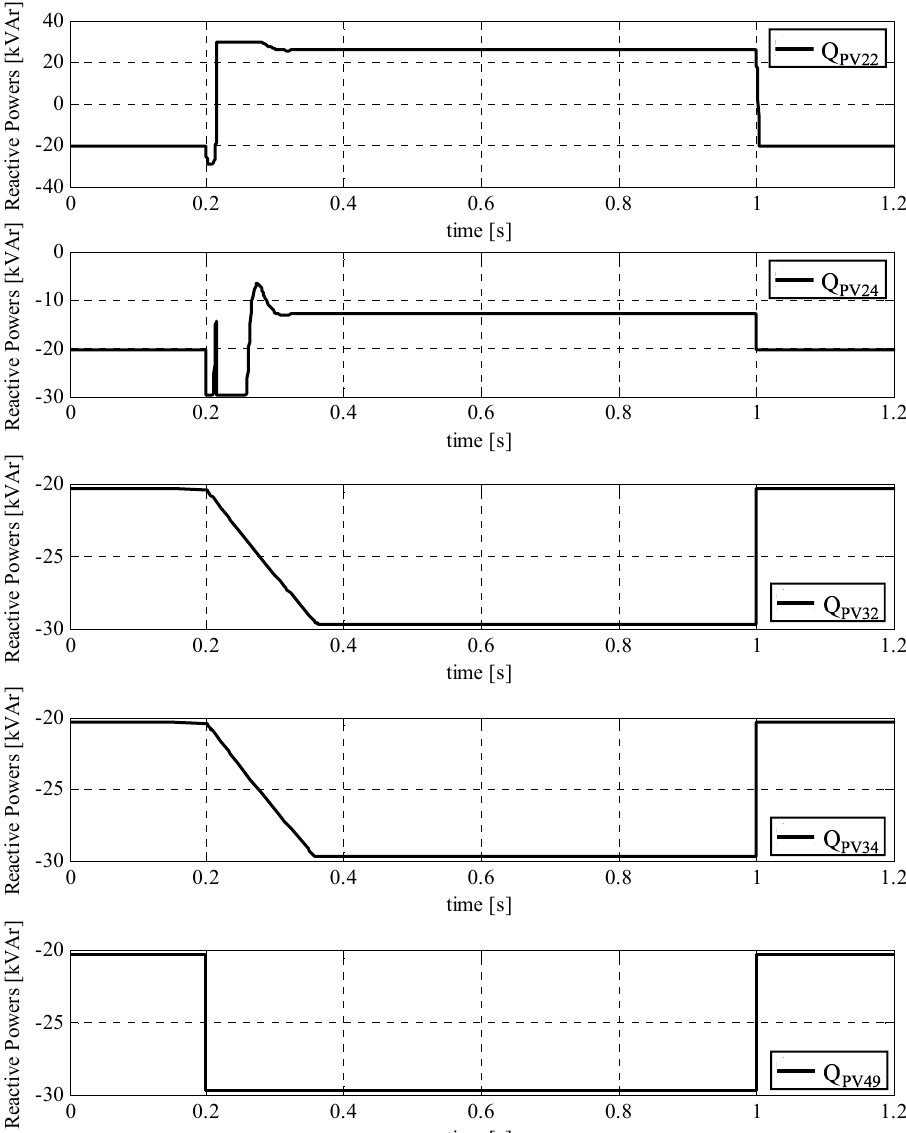
Figure 13. Time domain behavior of reactive power outputs of the PV-inverters connected at buses #22, 24, 32, 34, and 49.